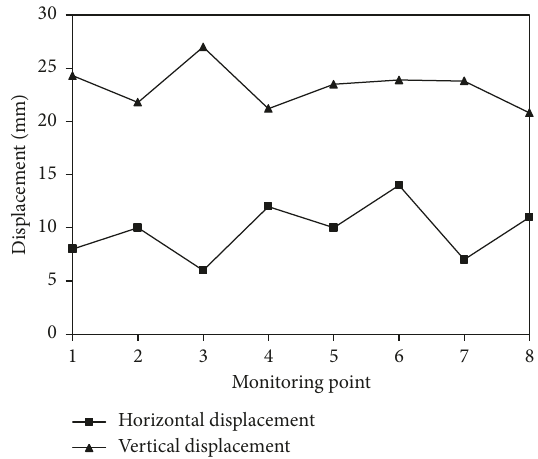
Figure 11: Displacements of bracing pillar after finishing con- struction of base plate.